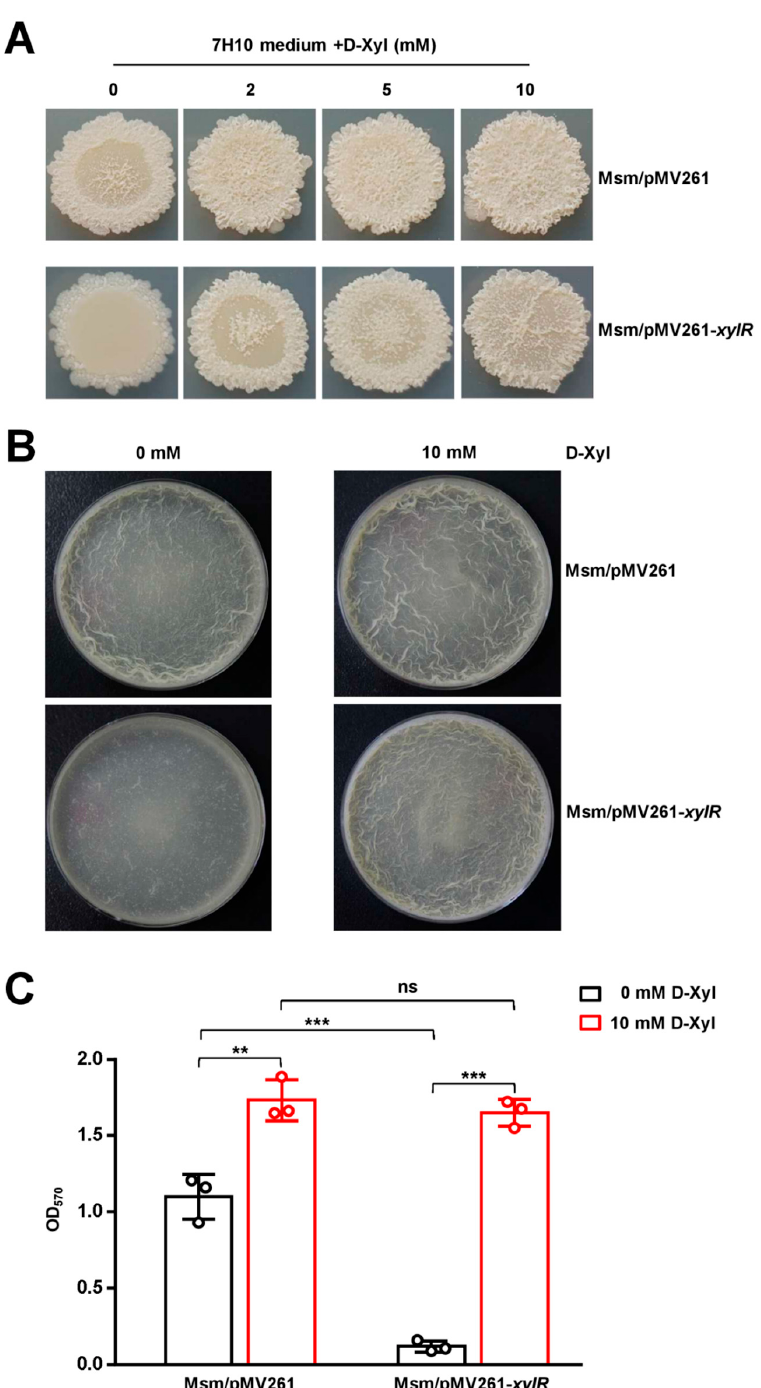
xylose, indicating that the xylR overexpression could effectively counteract the stimulatory role of D-xylose on the phenotype formation of M. smegmatis .